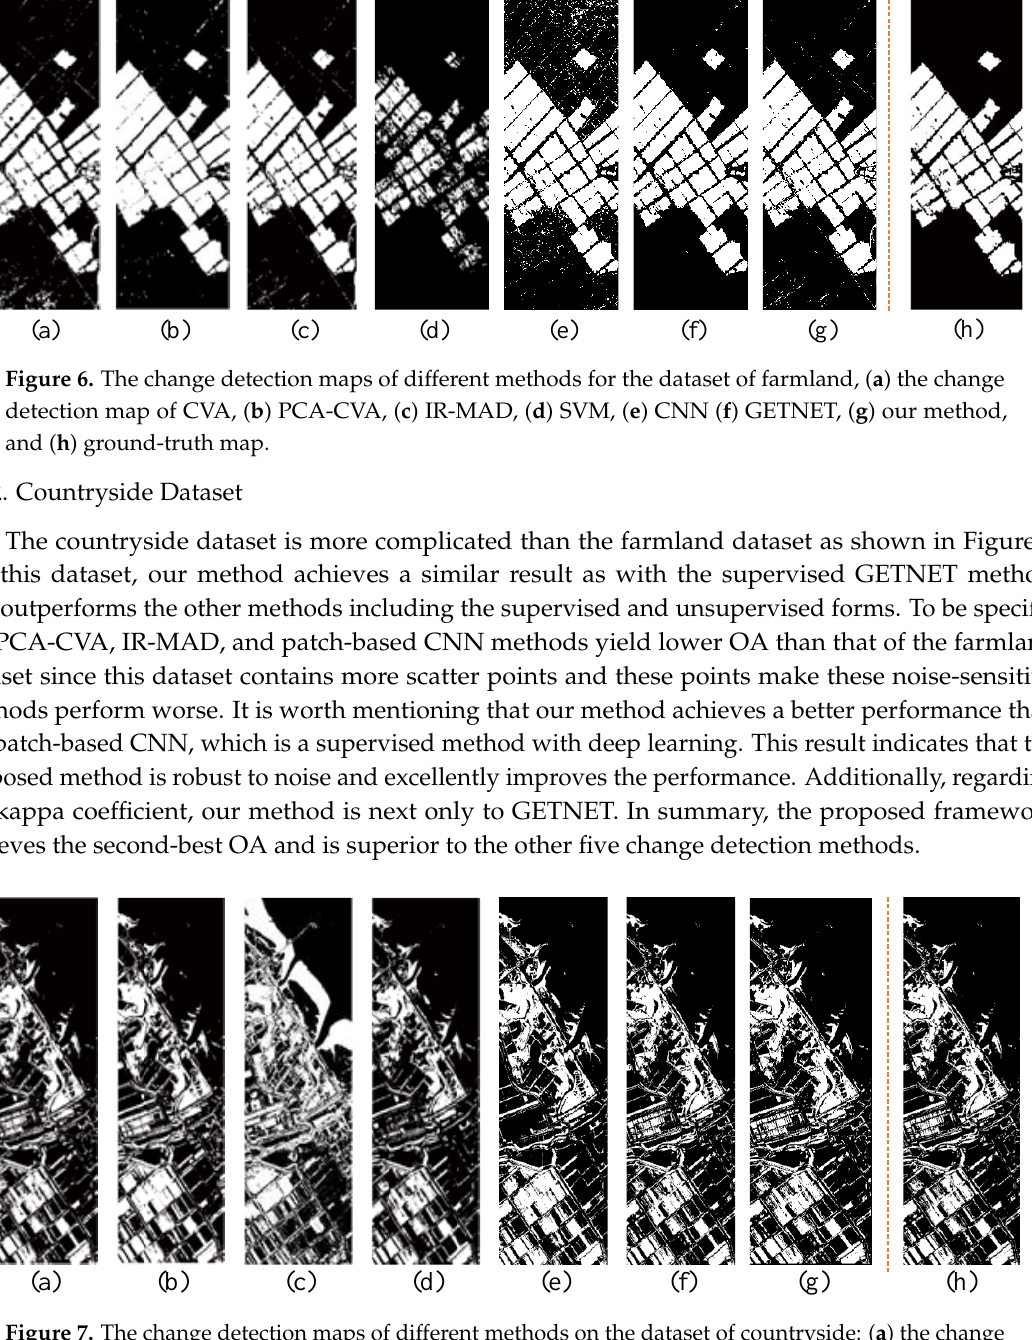
Figure 7. The change detection maps of different methods on the dataset of countryside: ( a ) the change detection map of CVA; ( b ) PCA-CVA; ( c ) IR-MAD; ( d ) SVM; ( e ) CNN; ( f ) GETNET; ( g ) our method; and ( h ) ground-truth